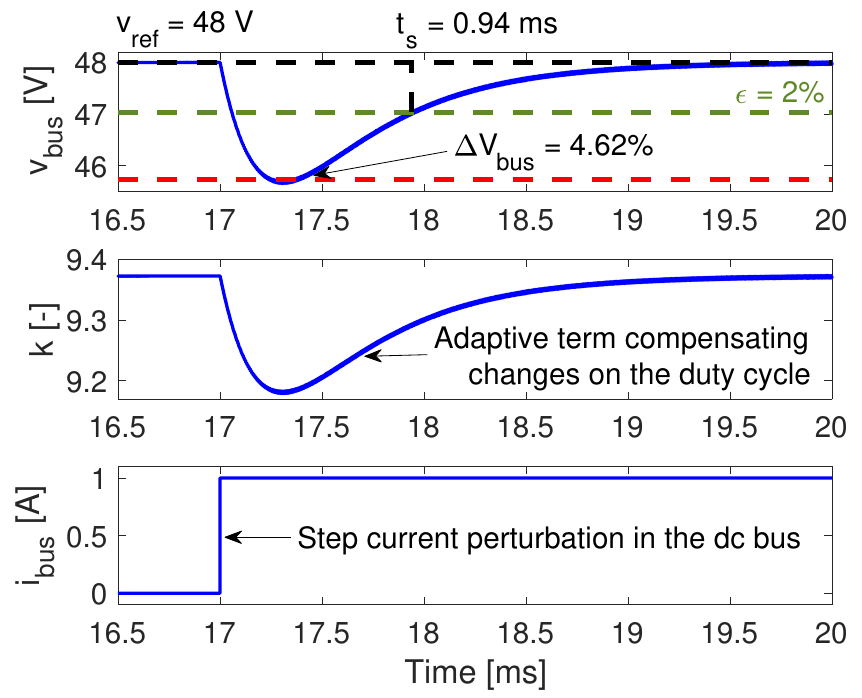
Figure 8. Response to step current